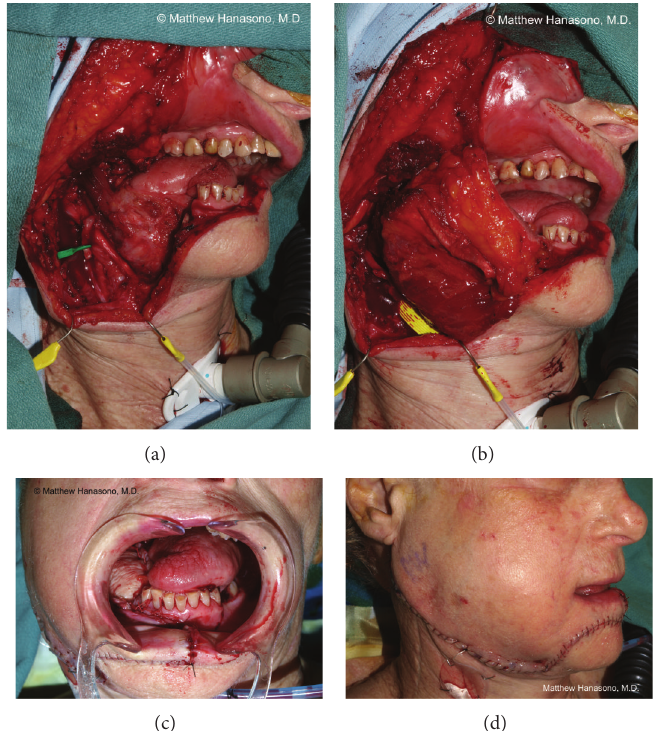
Figure 6: Posterior mandibular defect following tumor resection (a). Anterolateral thigh myocutaneous free flap inset (b). Skin paddle to close oral defect (c). External appearance